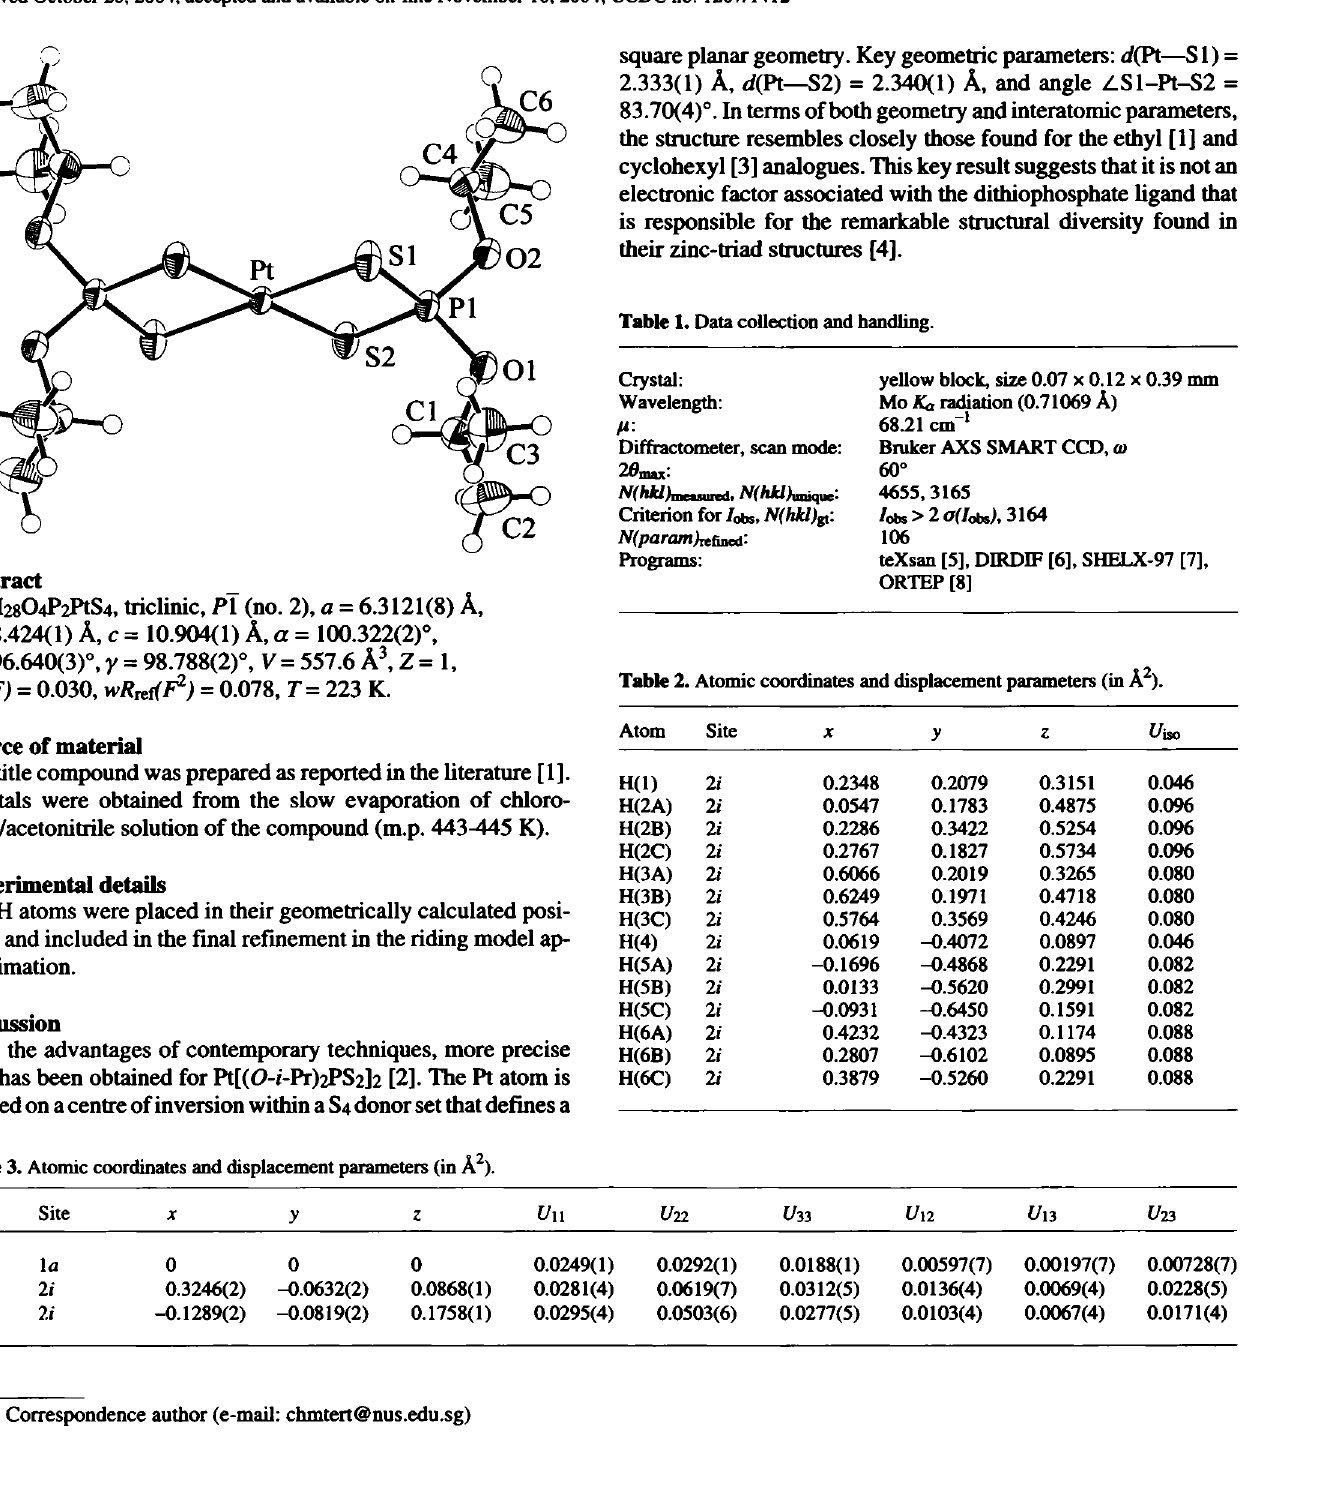
Table 1. Data collection and handling.